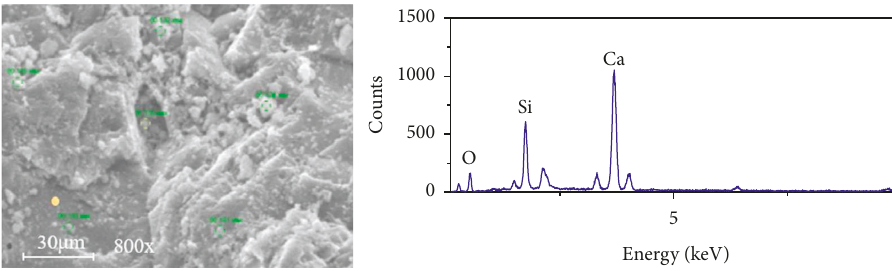
Figure 8: EDS image (scale bar 30 μ m).